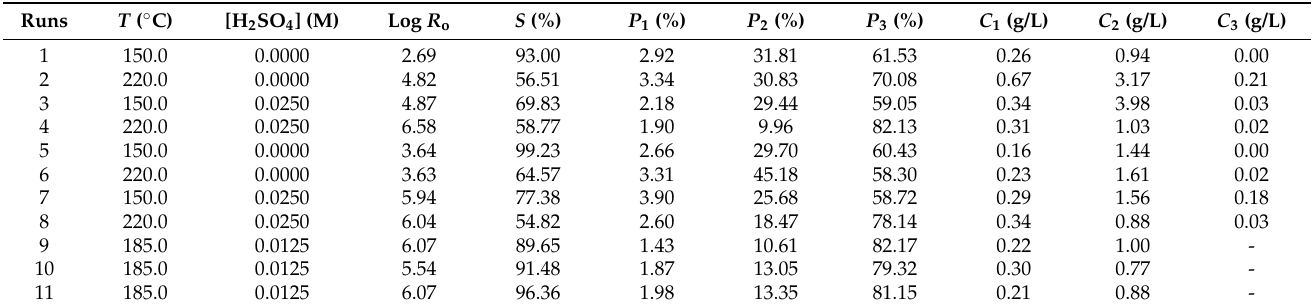
Table 2. Full factorial design matrix in the optimisation of thermochemical pretreatment conditions for young cellulosic fibers. Experimental responses ( S , P 1 , P 2 , P 3 , C 1 , C 2 , C 3 ) and Log R o .